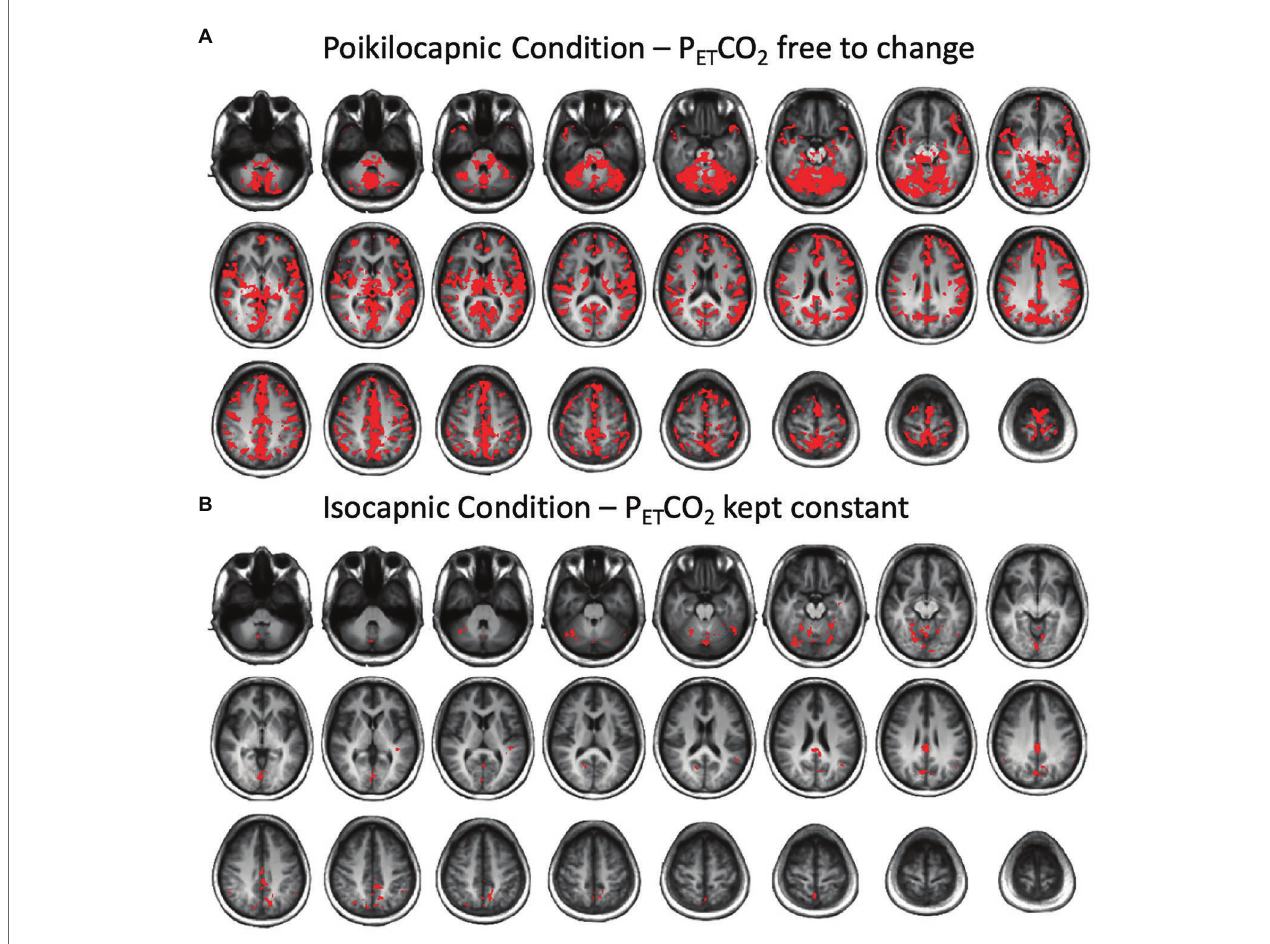
FIGURE 1 | Brain average maps displaying the correlations between the blood oxygenation level-dependent (BOLD) signal and end-tidal PCO 2 (P ET CO 2 ) time course resting state conditions after multiple comparison correction using threshold free cluster enhancement (TFCE) in (A) the poikilocapnic condition, and (B) the isocapnic condition. Significant regions at p < 0.05 are